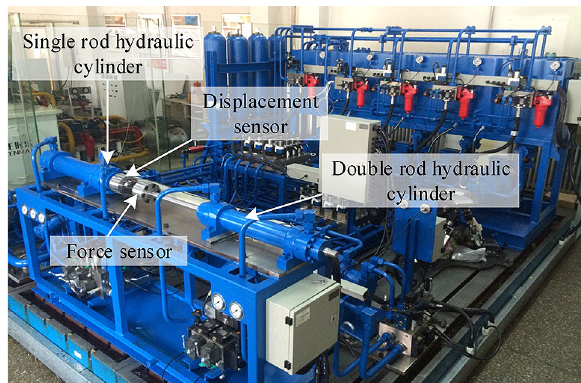
Figure 14. Experimental platform.